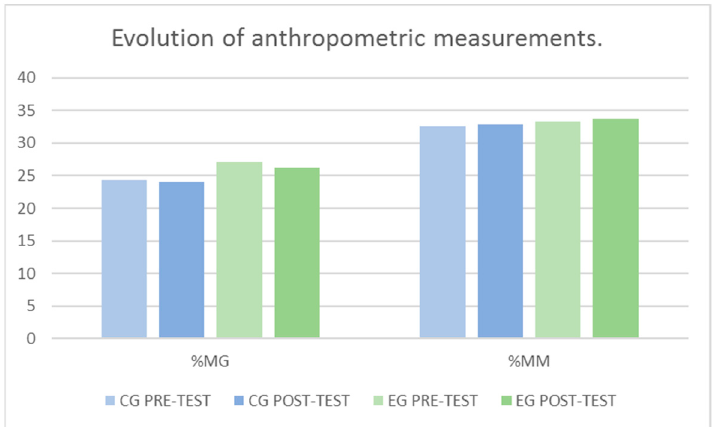
Figure 2. Evolution of the anthropometric measurements between groups and pre-post-test. %MG: body fat percentage; %MM: muscle mass percentage.